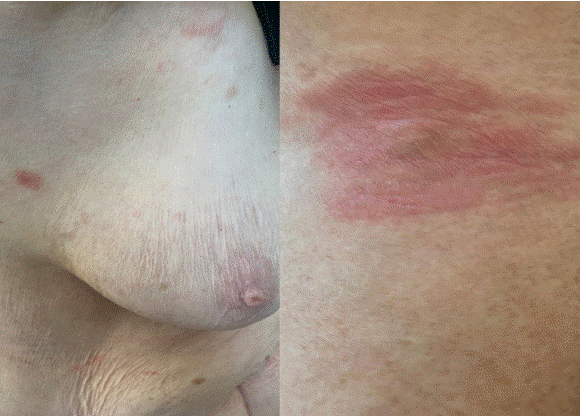
Figure 5. Erythematous and scaly plaque on the axillary fold histologically diagnosed as parapsoriasis.